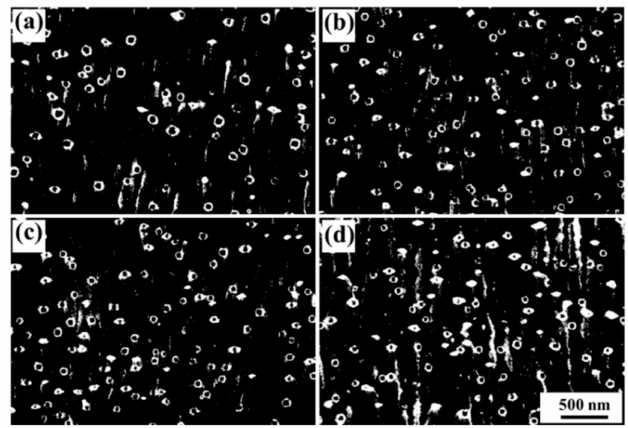
Figure5. High-magnificationSEMimagesof( a )C00, ( b )C01, ( c )C05and( d